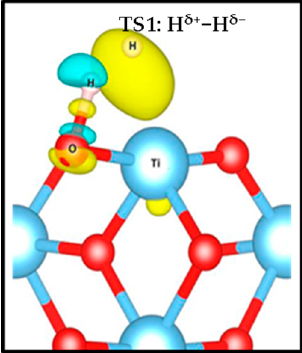
Figure 4. Charge density difference of transition state 1(TS1)illustrating the formation of the H δ + -H δ− tight ion pair on the (001) surface. Yellow and green iso-surfaces show an electronic density gain and depletion, respectively.